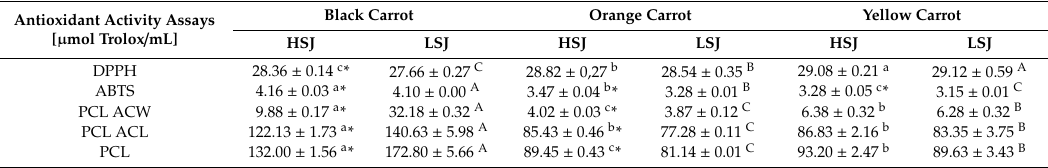
Table 2. The antioxidant activity of black, orange and yellow carrot juices determined by di ff erent assays. Black Carrot Orange Carrot Yellow Carrot Antioxidant Activity Assays [ µ mol Trolox / mL] HSJ LSJ HSJ LSJ HSJ LSJ